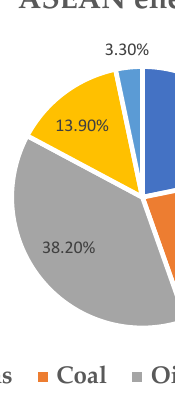
Figure 6. Energy mix of ASEAN by the end of 2018. Source: The 6th ASEAN Energy Outlook 2017 – 2040.